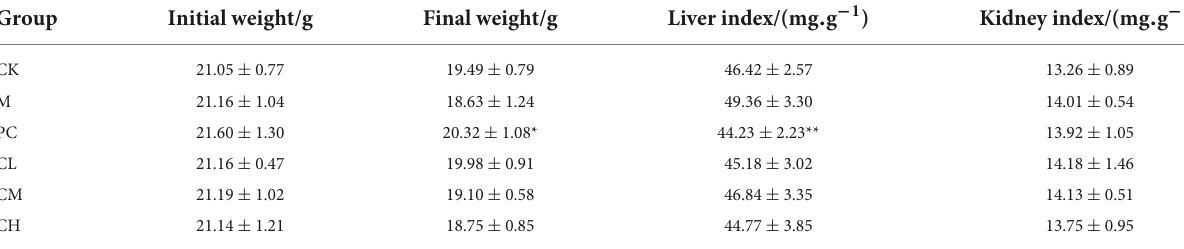
TABLE 1 Effect of samples on liver, kidney, and ovarian organ indices in mice.